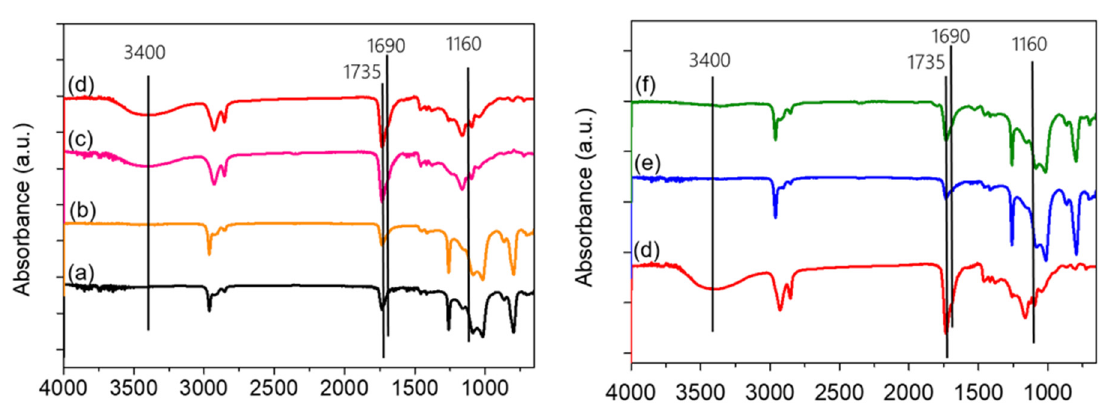
Figure 2. ATR-FTIR spectra of PGS ( a ), PGSE1 ( b ), PGSE2 ( c ), PGSE3 ( d ), PGSE-B ( e ) and PGSE-Z ( f ).